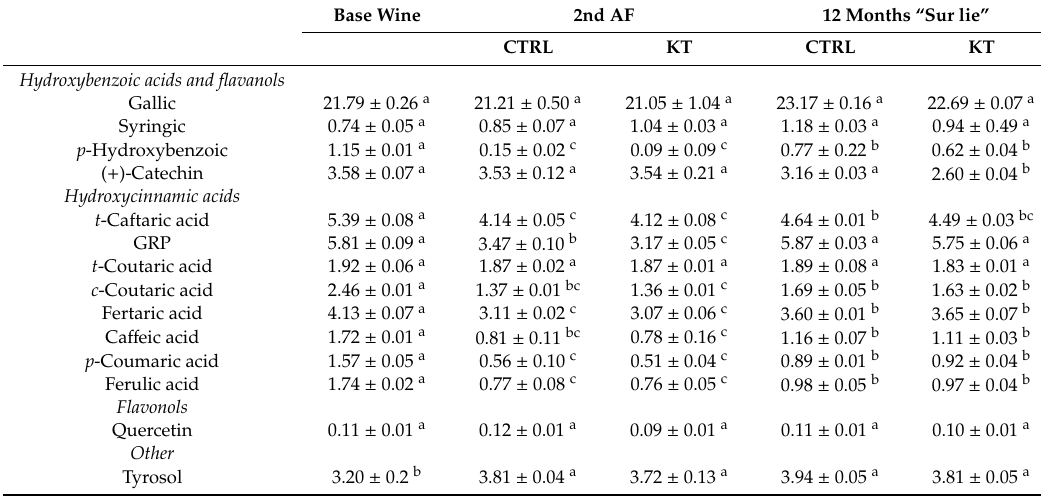
Table 3. Concentrations (mg / L) of phenolic acids after secondary alcoholic fermentation (2nd AF) and after 12 months of storage “sur lie.” In the same row, di ff erent letters indicate significant di ff erences according to Tukey’s test ( p < 0.05). n = 3. GRP = Grape reaction Product. Base Wine 2nd AF 12 Months “Sur lie” CTRL KT CTRL KT Hydroxybenzoic acids and flavanols